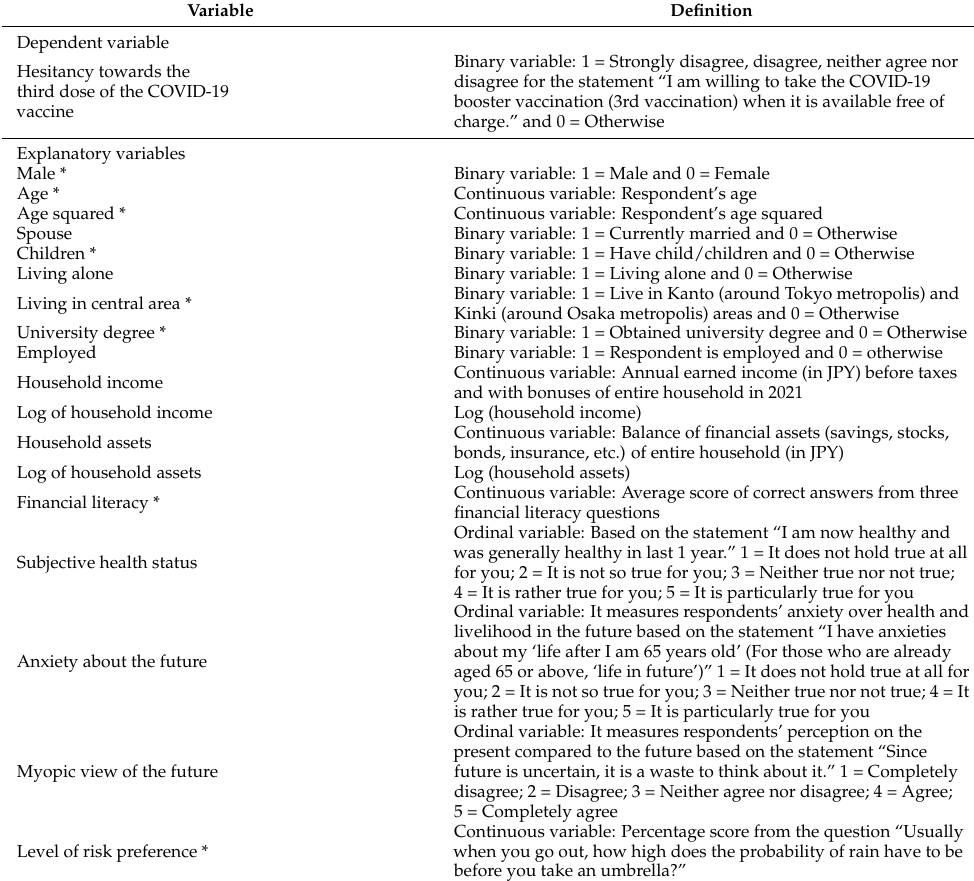
Table 1. Variable